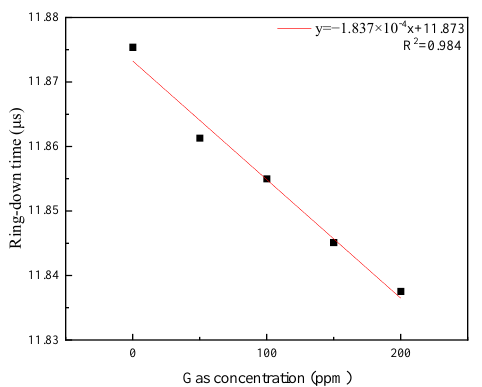
Figure 7. Fitting curve of exponential function corresponding to different CO concentrations.